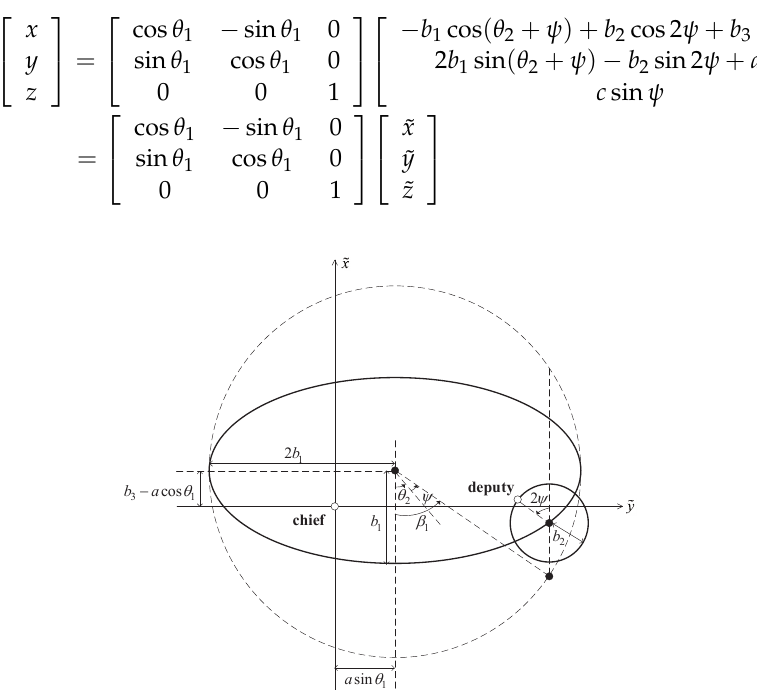
Figure 5. Illustration of the scale-independent relative orbital elements ( x − y plane).